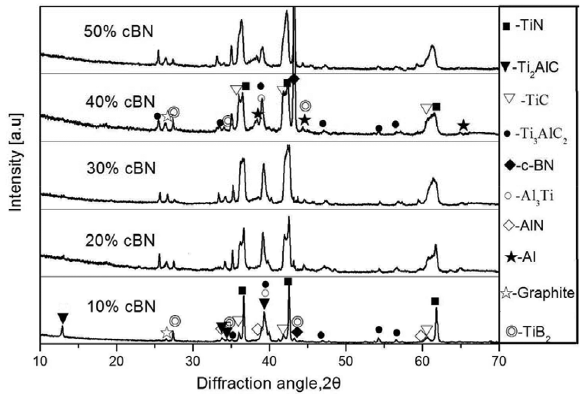
Figure 2: The XRD patterns of the samples that contained different c-BN contents obtained by SHS.